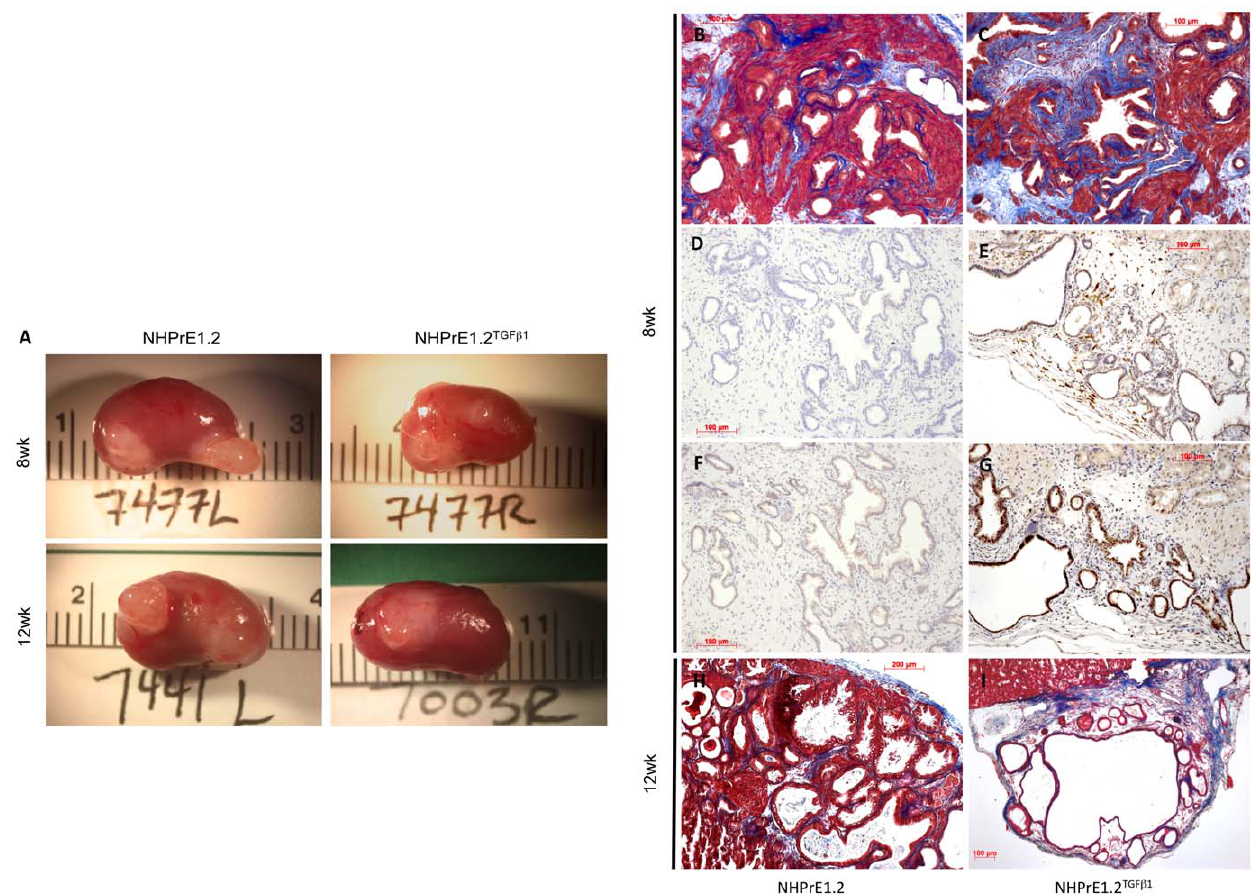
Figure 7. Tissue recombinants demonstrate TGF b 1-induced extracellular matrix deposition and inflammation. Panel A. Recombination of UGM plus NHPrE1.2 vs. NHPrE1.2-HA-TGF- b 1(a) demonstrates a decrease in graft size at both 8 and 12 weeks in recombinants that express HA-TGF- b 1(a). PanelsBandC. Trichrome staining demonstrates increased collagen production in HA-TGF- b 1(a) expressing human prostate epithelia compared to vector control. PanelsDandE. An increase in F4/80 positive macrophages is apparent in recombinants expressing HA-TGF- b 1(a). PanelsFandG. In addition, p65 activation is observed in both the epithelium and stroma in recombinants expressing HA-TGF- b 1(a). PanelsHandI. Control recombinants at 12 weeks maintain glandular acini structure and overall morphology, whereas recombinants made with HA- TGF- b 1(a) epithelium exhibit atrophic and attenuated acini. Images B-I captured at 6 100.